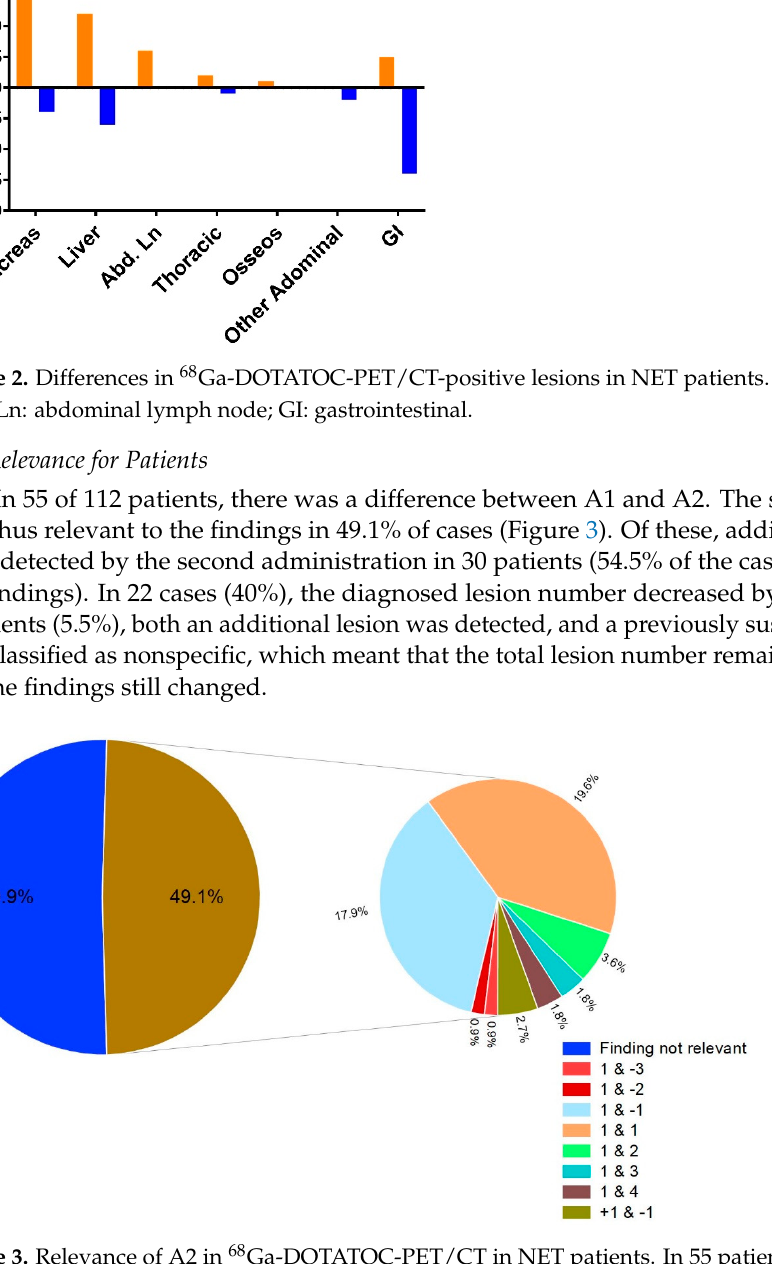
Figure 3. Relevance of A2 in 68 Ga-DOTATOC-PET/CT in NET patients. In 55 patients (49%), there was a difference between A1 and A2 and thus relevance of the findings of the biphasic acquisition (left pie chart). In the right pie chart, the cases are divided proportionally according to the differences in A1 and A2. The positive numbers (red) represent additional lesions seen in A2 compared to A1 (54.6% overall), whereas the negative numbers (blue) represent a corresponding reduction in the described lesions (40%). The purple portion corresponds to cases in which an additional lesion was detected and negated elsewhere (5.5%). Table 3. Distribution of all 68 Ga-DOTATOC-PET/CT examinations relevant to report.